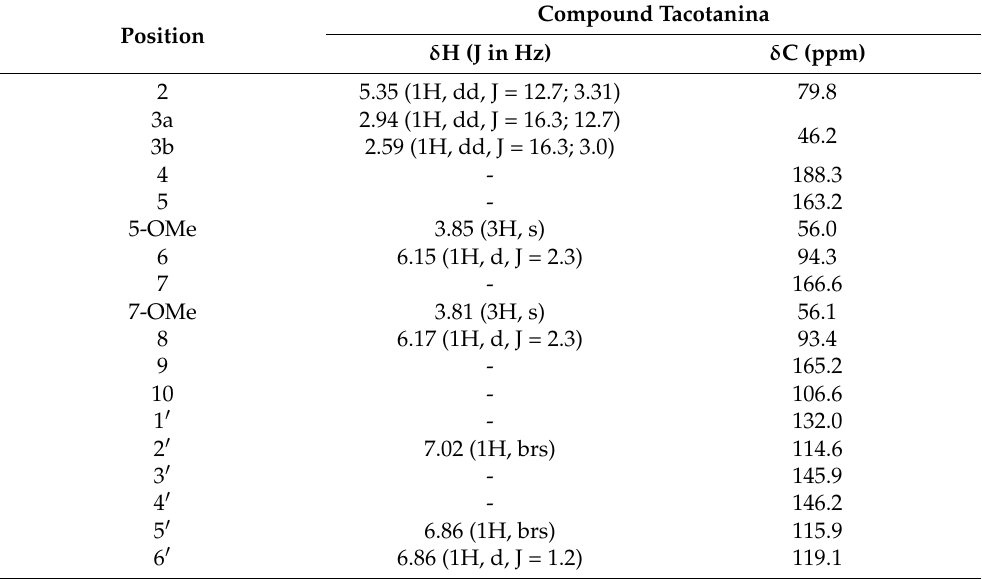
Table 1. 1 H NMR and 13 C NMR (300 MHz, Acetone-d 6 ) spectral data for the flavonoid Tacotanina.